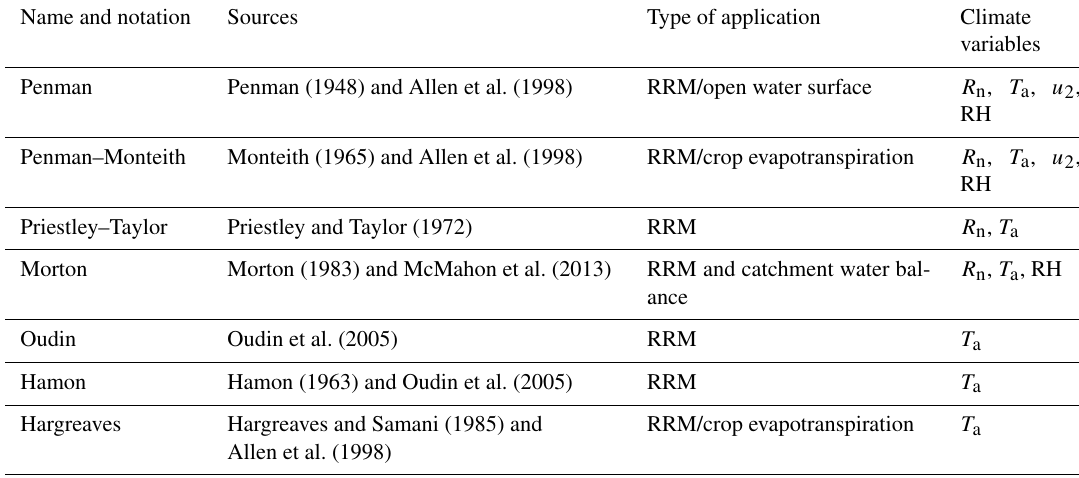
Table 2. The seven formulations used to compute PE. The “Climate variables” column refers to the input data required in each PE formulation. R n is net radiation, RH is relative humidity, u 2 is 2m wind speed and T a is 2m air temperature. Full equations are available in the provided R code (see the “Code availability” section). The Penman–Monteith method is from FAO 56. The Hamon formulation uses theoretical sunshine hours (Oudin et al., 2005; Almorox et al., 2015). RRM refers to rainfall–runoff